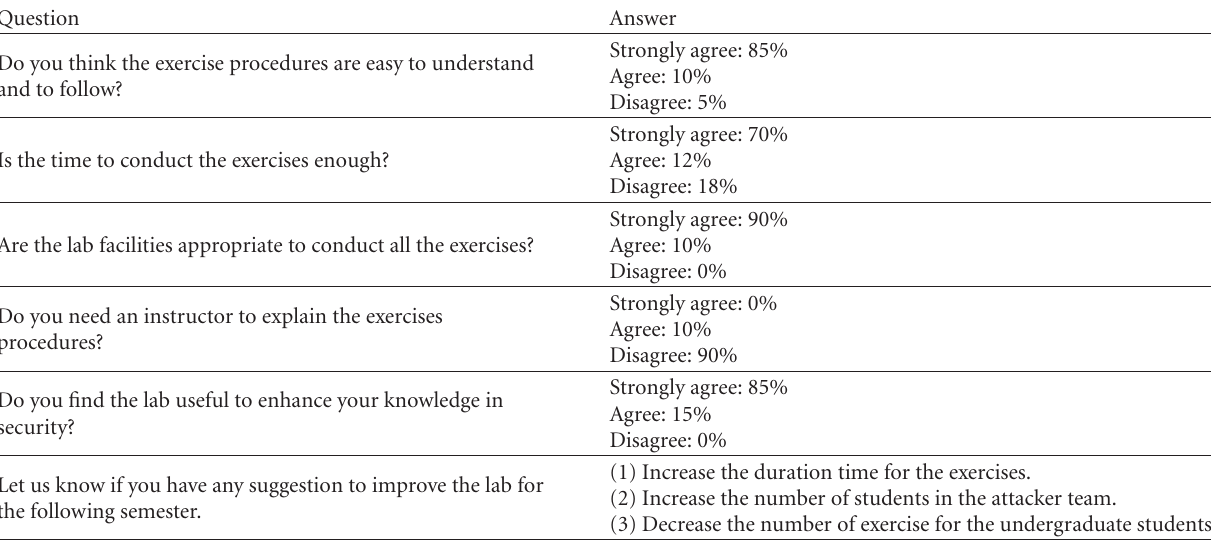
Table 4: Lab evaluation results from viewpoint of the